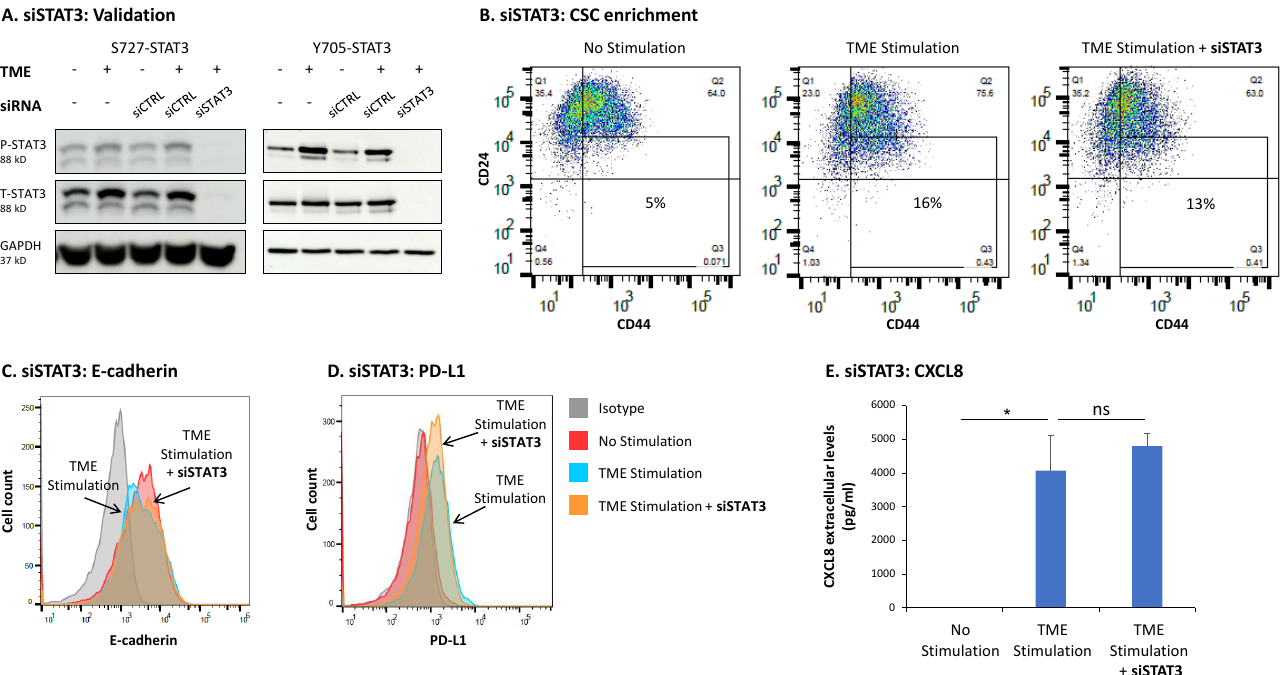
Figure 6. STAT3 knock-down does not affect the TME Stimulation-driven intrinsic and TME-related pro-metastatic traits of HR+/HER2 − breast cancer cells: MCF-7 cells were transiently transfected with siRNA to STAT3 (siSTAT3) or control siRNA (siCTRL) and were exposed to TME Stimulation (TME; concentrations as described in Figure 1) or treated by vehicle control (“No Stimulation”). ( A ) The ability of siSTAT3 to down-regulate STAT3 expression and phosphorylation was determined after 96 h of TME Stimulation on Y705-STAT3 and S727-STAT3 phosphorylation, by WB analyses. ( B – E ) Functional effects of STAT3 KD, determined after 96 h of TME Stimulation, as described in Figure 1. In panels ( B – E ), the results are from a representative experiment of n ≥ 3, showing similar results. * p < 0.05. ns, not significant. Results obtained from similar studies of CSC enrichment